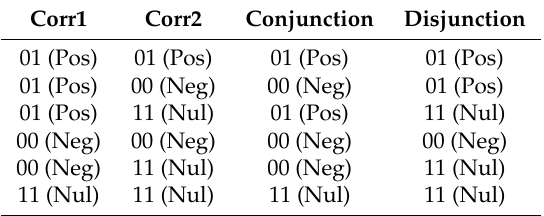
Table 1. The table specifies the results of conjunction and disjunction as binary operators on two correlation values, Corr1 and Corr2, that refer to a correlation with the same semantic value irrespective of the type of the value. Therefore, the entire range of semantic space under consideration may be accounted for as elemental ranges of values of overlap to determine the results of conjunction or disjunction operators. While the table gives comprehensive results for the conjunction operator, it falls short in quantifying the abstraction as a result of disjunction, as discussed in the text. Corr1 Corr2 Conjunction Disjunction 01 (Pos) 01 (Pos) 01 (Pos) 01 (Pos) 01 (Pos) 00 (Neg) 00 (Neg) 01 (Pos) 01 (Pos) 11 (Nul) 01 (Pos) 11 (Nul) 00 (Neg) 00 (Neg) 00 (Neg) 00 (Neg) 00 (Neg) 11 (Nul) 00 (Neg) 11 (Nul) 11 (Nul) 11 (Nul) 11 (Nul) 11